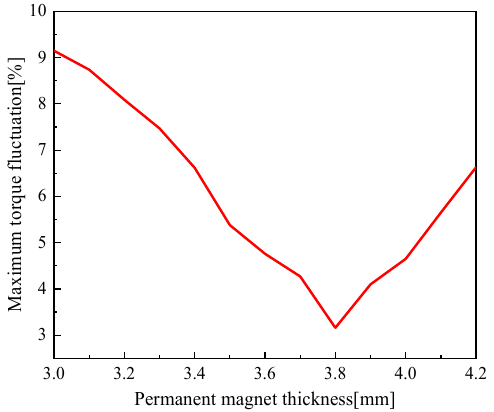
Figure 12. Relationship between permanent magnet thickness and cogging torque.